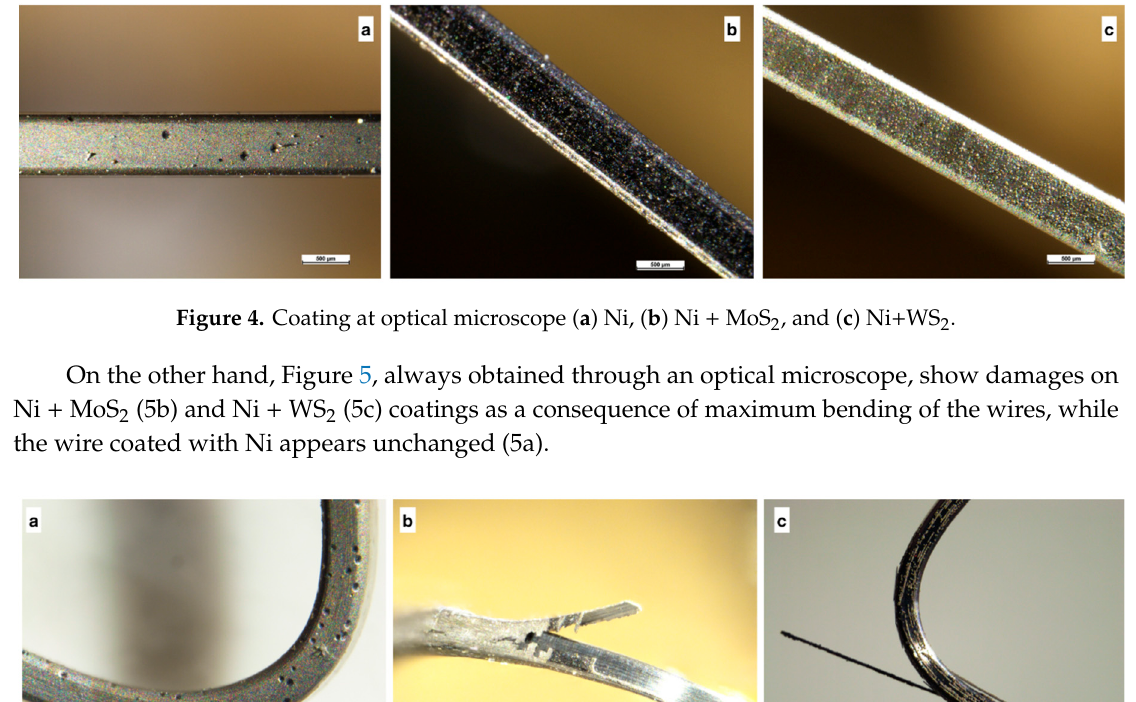
Figure 5. Fractures at optical microscope ( a ) Ni, ( b ) Ni + MoS 2 , and ( c ) Ni + WS 2 .